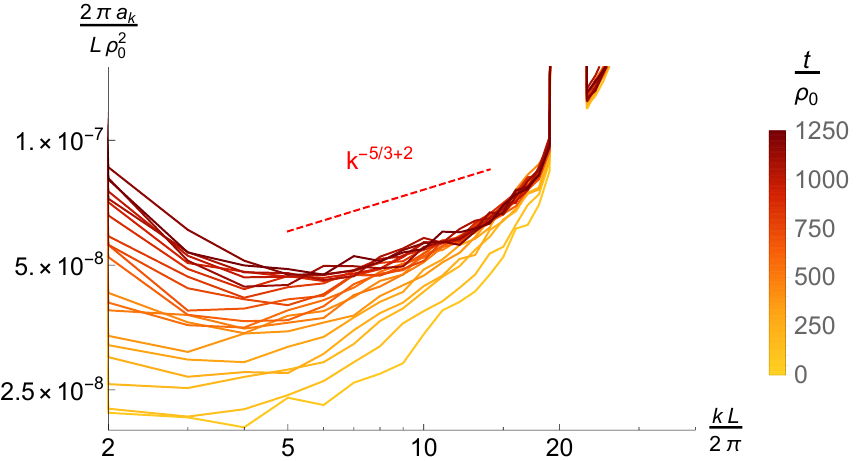
Figure 7 . A plot of the horizon area power spectrum, defined in (5.11) as a function of momentum for different times, ensemble averaged over 36 runs. The fit to a − 5 / 3 + 2 power law is inline with other indications for this scaling described in the literature and discussed in the main